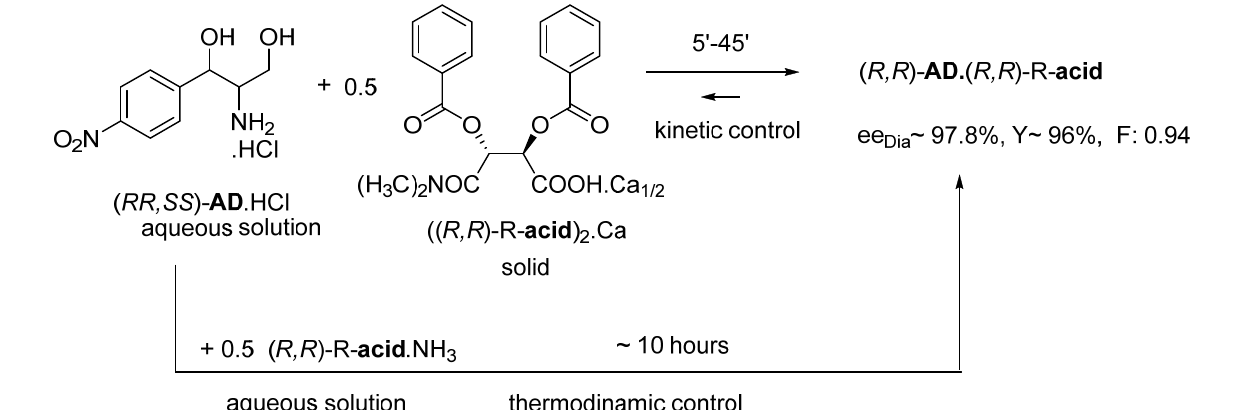
Figure 10. Solution-solution reaction (thermodynamic control) and solution-solid reaction (kinetic control).